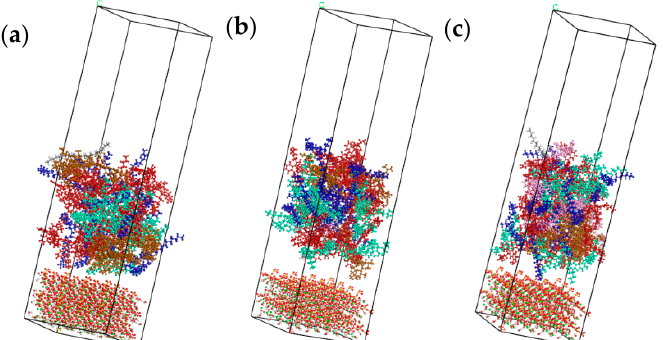
Figure 8. Interface adhesion models for different asphalt types. ( a ) Model A (70# asphalt); ( b ) Model B (PG76-22 modified asphalt); ( c ) Model C (S-HV modified asphalt).